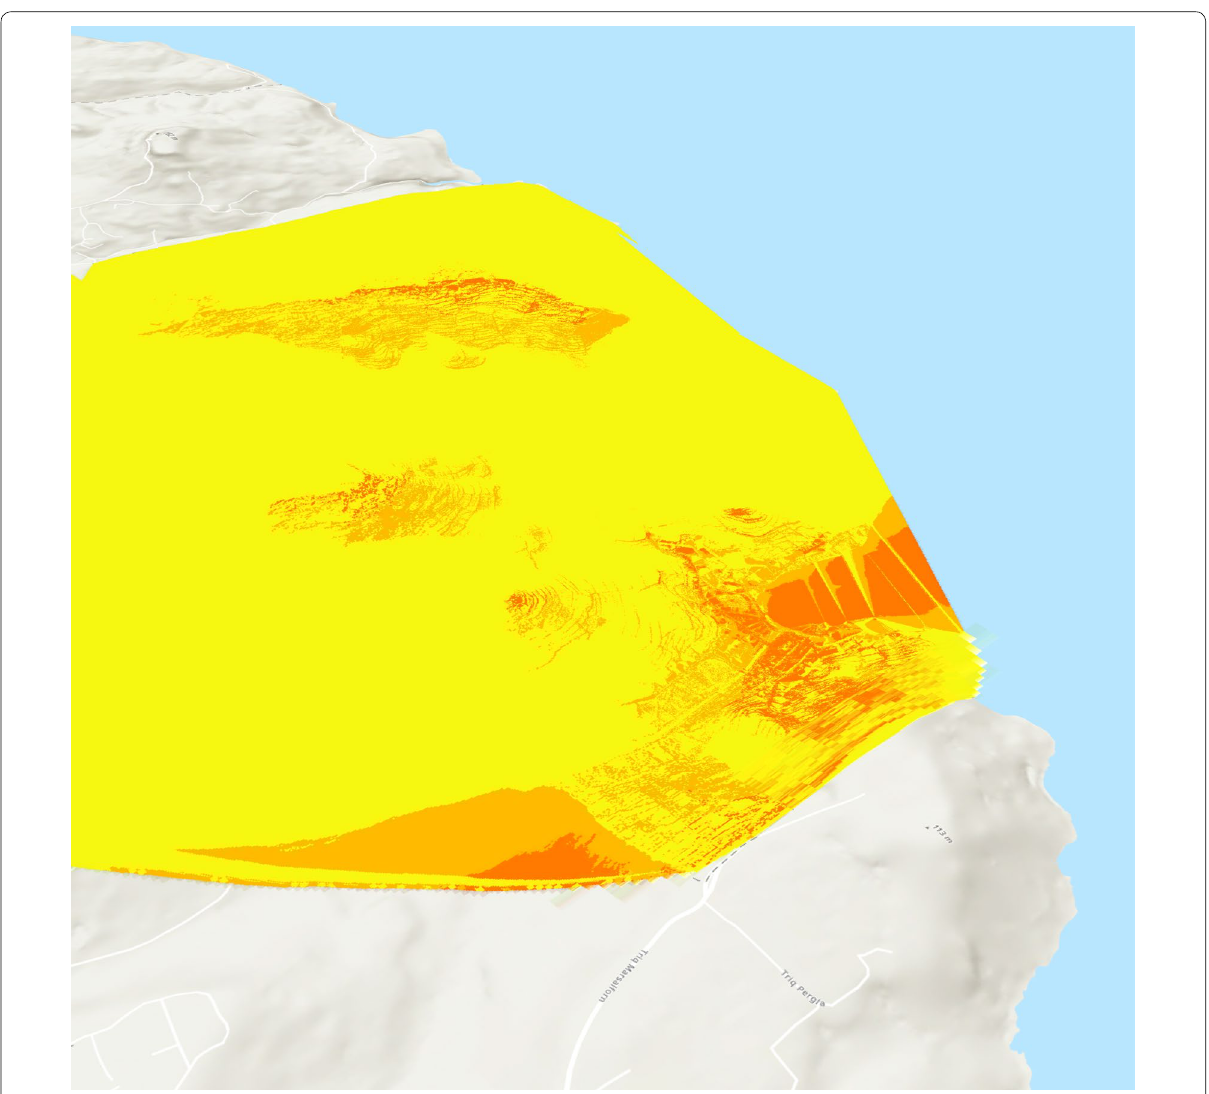
Fig. 13 Visibility gap area for Marsalforn (before and after